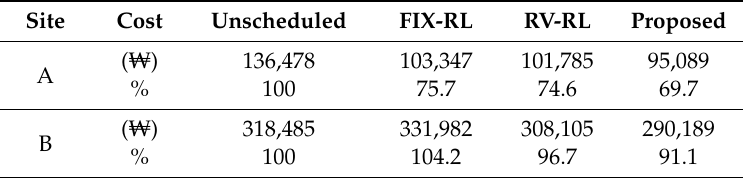
Table 2. Normalized total cost over test period. 390